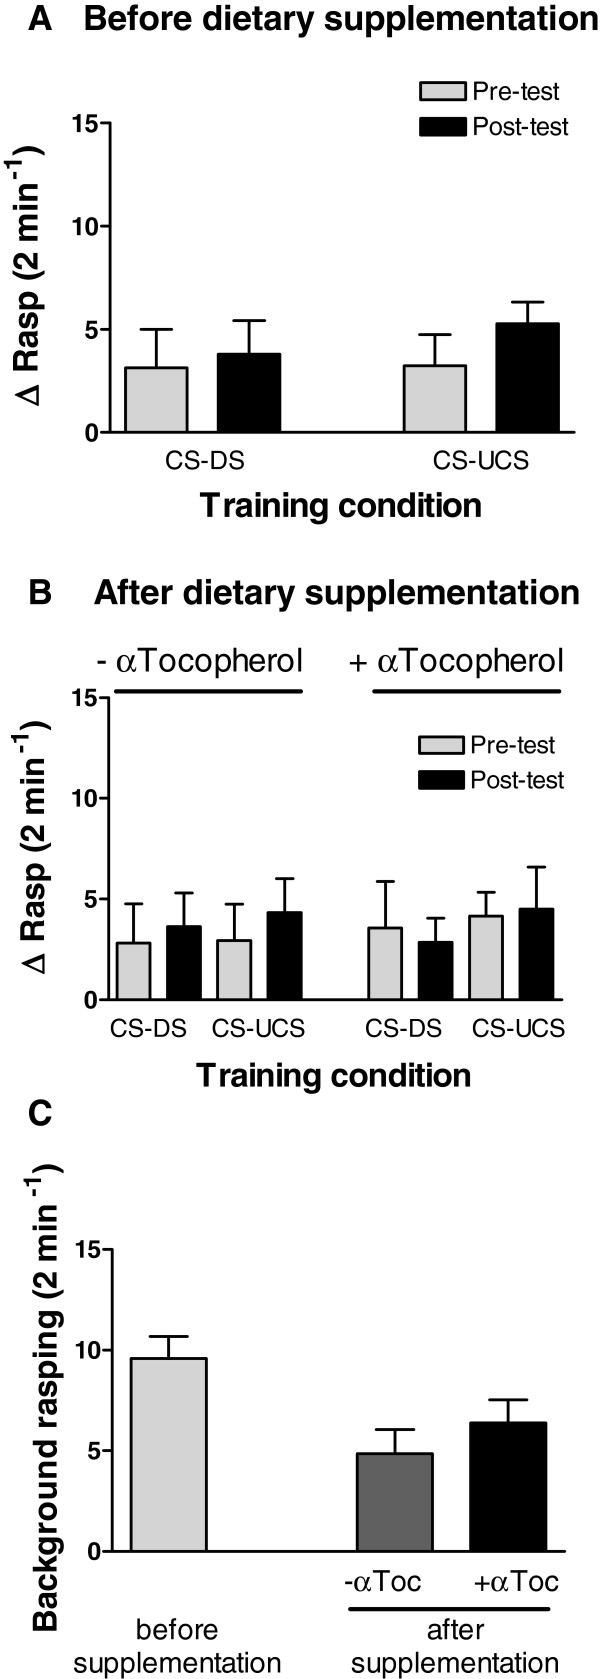
Effect of dietary α-tocopherol supplementation on LTM performance in senior animals. A . Long-term memory assessment of senior snails before the start of dietary supplementation with α-tocopherol. None of the control (CS-DS) or conditioned (CS-UCS) animals displayed a significant increase in the ΔRasp value indicative of LTM impairment. B. Long-term memory assessment of senior snails following 2 months of α-tocopherol dietary supplementation (+ αTocopherol) or vehicle only (− αTocopherol). Neither α-tocopherol or vehicle treated animals displayed an improvement in LTM performance C. Comparison of spontaneous background rasping rates reveals no significant differences between animals treated with α-tocopherol (+ αToc) or vehicle only (−αToc).